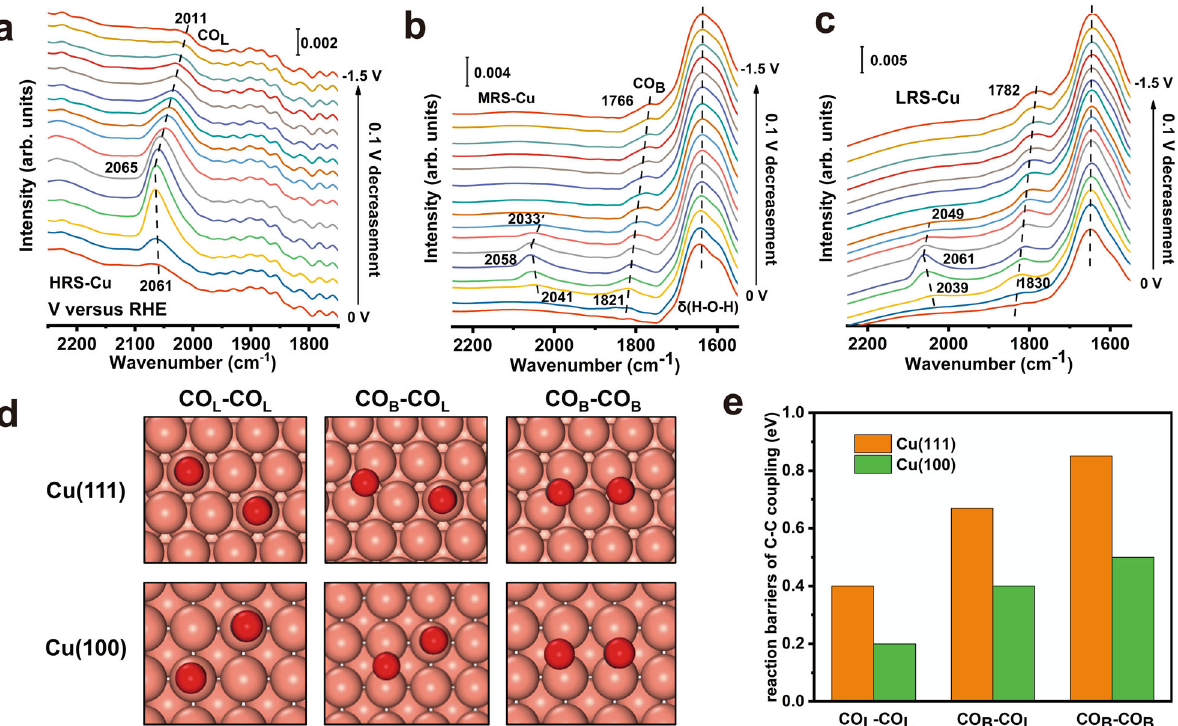
Fig. 3 Spectroscopic investigations of various Cu fi lms and DFT calculations on different Cu facets. In situ ATR-SEIRAS spectra of a HRS-Cu; b MRS-Cu; c LRS-Cu; d adsorption geometry for different C − C coupling precursors (i.e., CO L − CO L , CO B − CO L , CO B − CO B ), where solvent molecules are not presented to show the adsorbate con fi gurations; e reaction barriers for C − C coupling from different precursors on Cu(100) and Cu(111) facets.